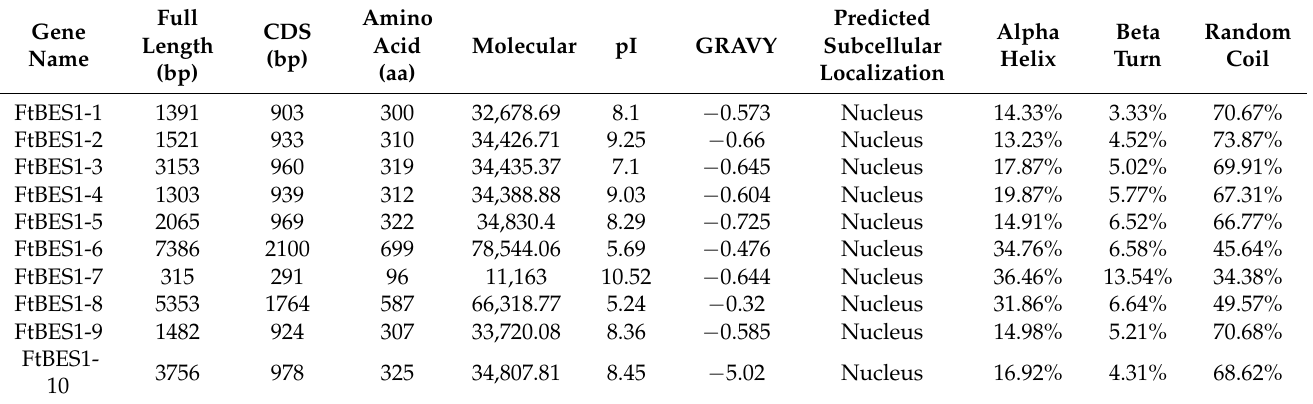
Table 1. Physicochemical properties of FtBES1 gene family